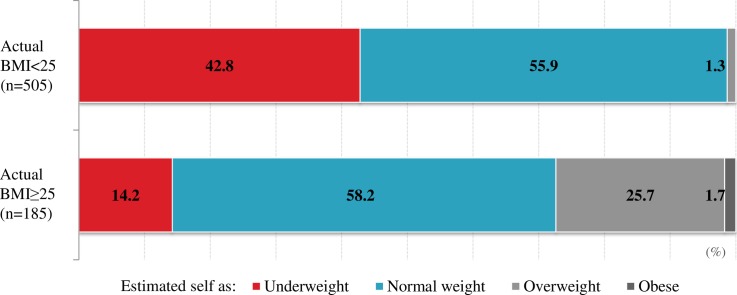
Estimation of body weight by BMI.